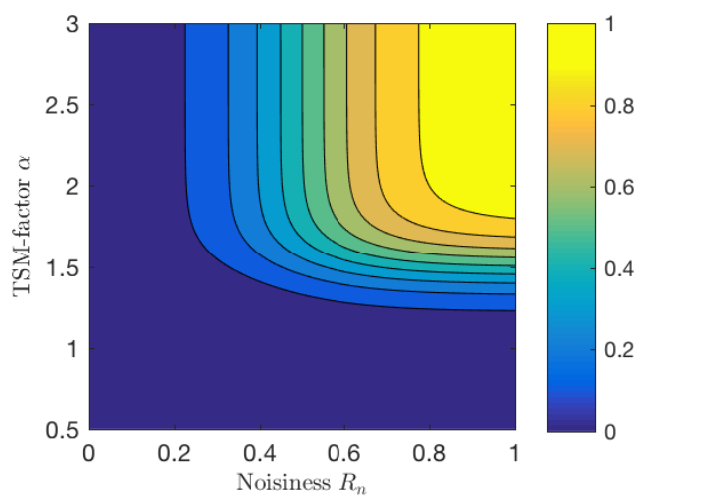
Figure 5. A contour plot of the phase randomization factor A n , with b n = b α = 4. TSM: time-scale